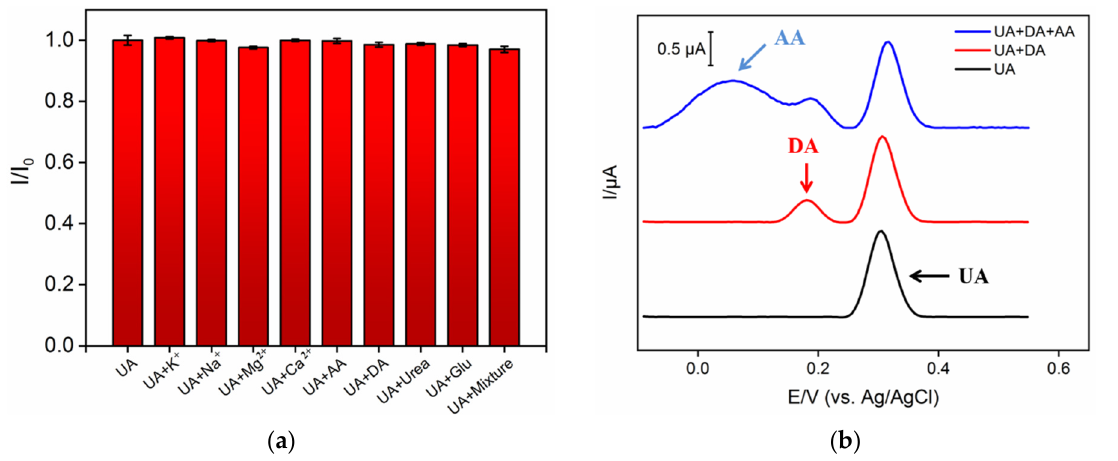
Figure 6. ( a ) The peak current ratio of UA (10 μ M) on NH 2 -VMSF/ErGO/SPCE in absence (I 0 ) or presence (I) of one or mixture. ( b ) Differential pulse voltametric curves of UA on NH 2 -VMSF/ErGO/SPCE in the absence or presence of AA (10 μ M) or DA (10 μ M).